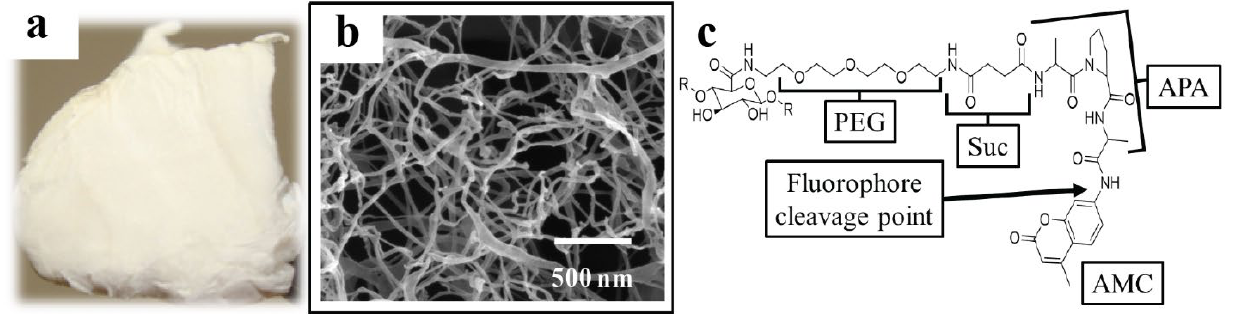
Figure 1. ( a ) Optical and ( b ) FE-SEM images of tNFC. The FE-SEM images were produced at 80,000× magnification with a 500 nm scale, and ( c ) the major components of the linker–fluorogenic elastase substrate, which is composed of PEG linker, Suc-APA elastase substrate, and AMC fluorophore. The AMC cleavage point is highlighted by the arrow.